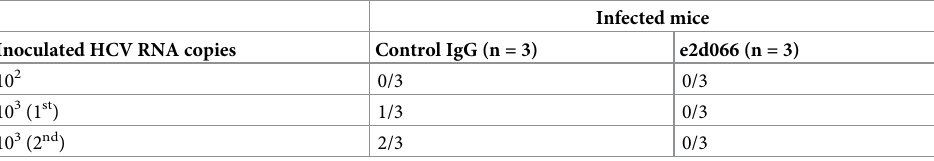
Table 4. Neutralizing effect of e2d066 against J6/JFH-1 HCVcc infection in human liver chimeric